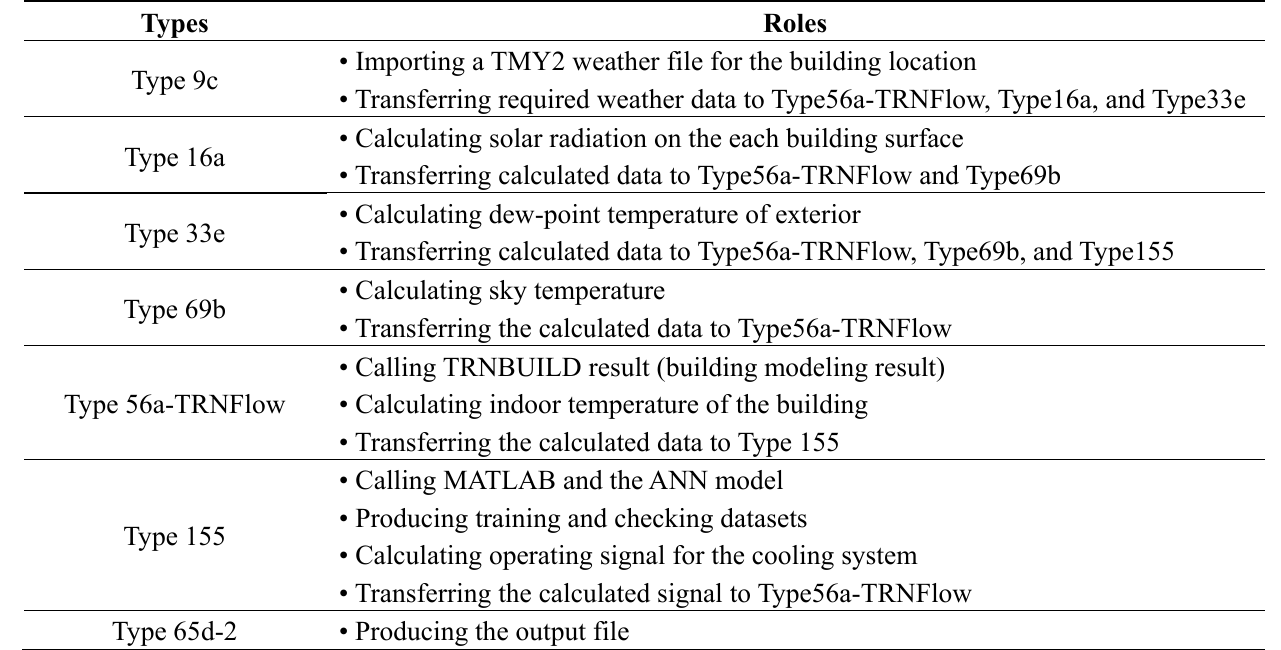
Table 4. Roles of Transient Systems Simulation (TRNSYS) types.